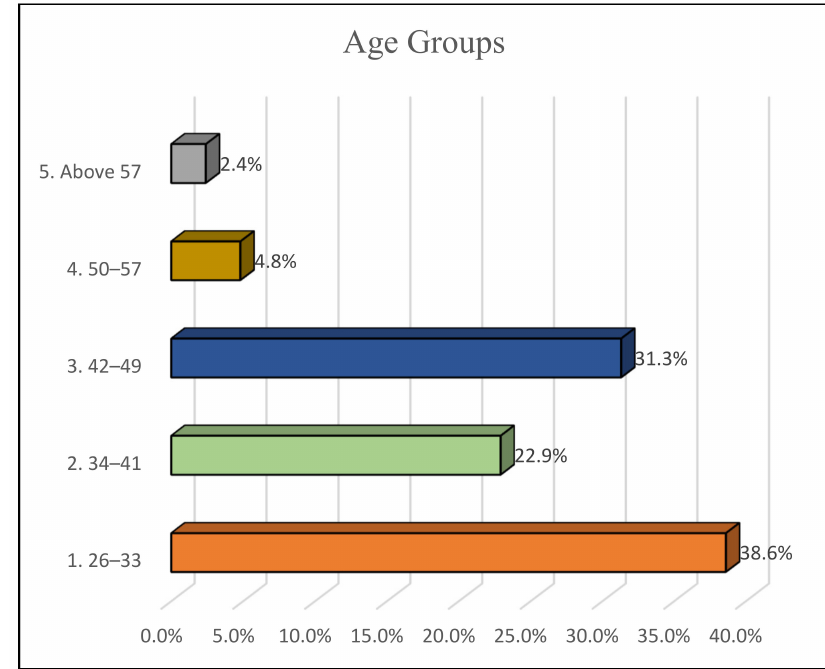
Figure 4. Age Distribution